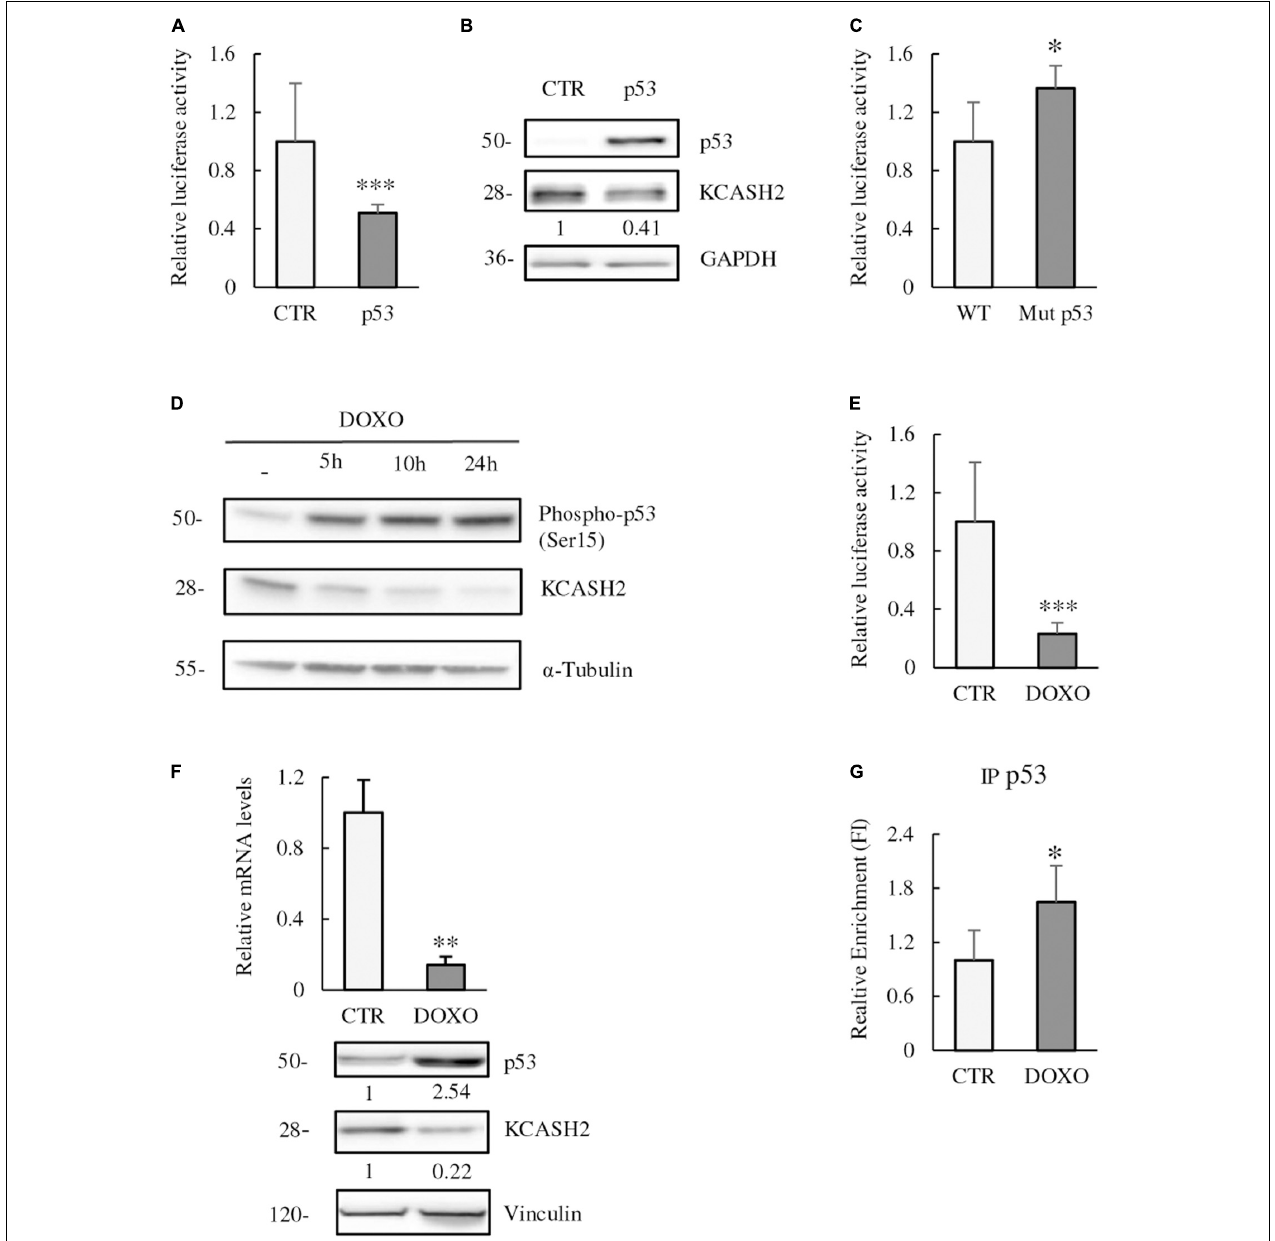
FIGURE 4 | p53 is a negative regulator of KCASH2 transcription. (A,B) p53 ectopic expression leads to a decrease in KCASH2 activity. (A) HEK293T cells were co-transfected with KCASH2-Luc reporter, together with an empty vector or a p53 expressing vector. Lysates were analyzed by luciferase assays. ∗ p < 0.05. (B) HEK293T cells were transfected with p53 expressing or empty vector. Protein lysates were analyzed by Western blot, using p53 and KCASH2 antibodies. GAPDH was used as loading control. (C) KCASH2 promoter mutated on the p53 BS loses responsiveness to p53. HEK293T were co-transfected with WT or Mut p53 luciferase vector. Lysates were analyzed through luciferase assays. ∗ p < 0.05. (D–F) Increase of p53 activity leads to a reduced KCASH2 expression. (D) HEK293T cells were treated with DOXO (5 µ M) and collected at different time points (5, 10, and 24 h). Western blot analysis of p53 activation was performed with an antibody against phosphorylation of its Ser15, KCASH2 levels with specific antibody. Anti-Tubulin was used as loading control. (E) Luciferase assay of HEK293T cells co-transfected with KCASH2-Luc reporter and treated with DOXO (5 µ M) for 24 h. ∗∗∗ p < 0.001. (F) Modulation of KCASH2 mRNA and protein levels following treatment with DOXO (5 µ M) for 10 h. mRNA (upper panel) was assayed through RT-qPCR, normalized to GAPDH and Actin, and represented as fold induction on the CTR. ∗∗ p < 0.01. The corresponding levels of p53 and KCASH2 proteins (lower panel) were analyzed by Western blot. Anti-Vinculin was used as loading control. Transfection efficiency in luciferase experiments was normalized by co-transfection of a pRL–TK–Renilla reporter. Data are representative of three experiments performed in triplicate and presented as mean ± SD. (G) p53 binds in vivo KCASH2 promoter. Chromatin IP assay was performed with control IgG or anti-p53 antibody. Cross-linked chromatin was extracted from HEK293T cells treated for 5 h with Doxorubicin 5 µ M and immunoprecipitated. Immunoprecipitated chromatin samples were analyzed by qPCR using KCASH2 promoter selective primers. Relative enrichment was calculated by Delta CT analysis and is expressed as fold induction of treated vs. not treated. ∗ p <